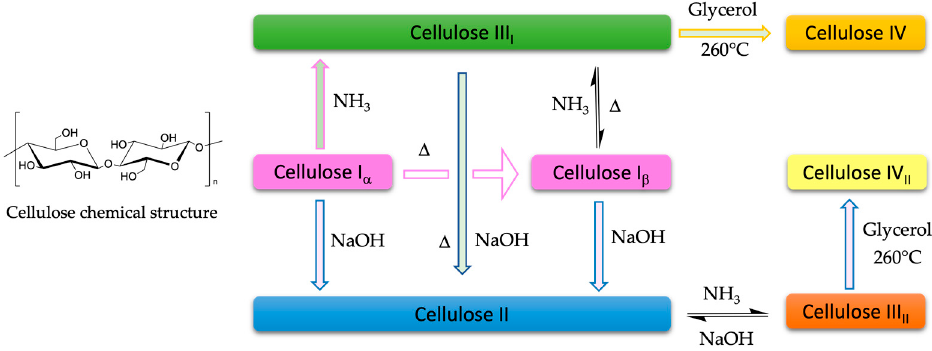
Figure 1. Diagram of the polymorph syhthesize of cellulose [12].